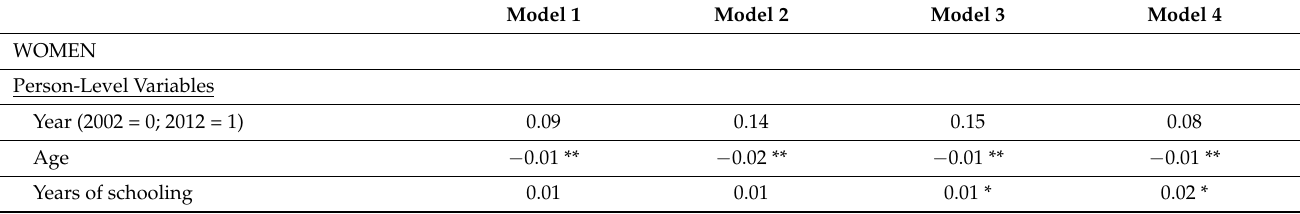
Table 2. Robust regression of satisfaction with family life on gender role norms and explanatory variables: married